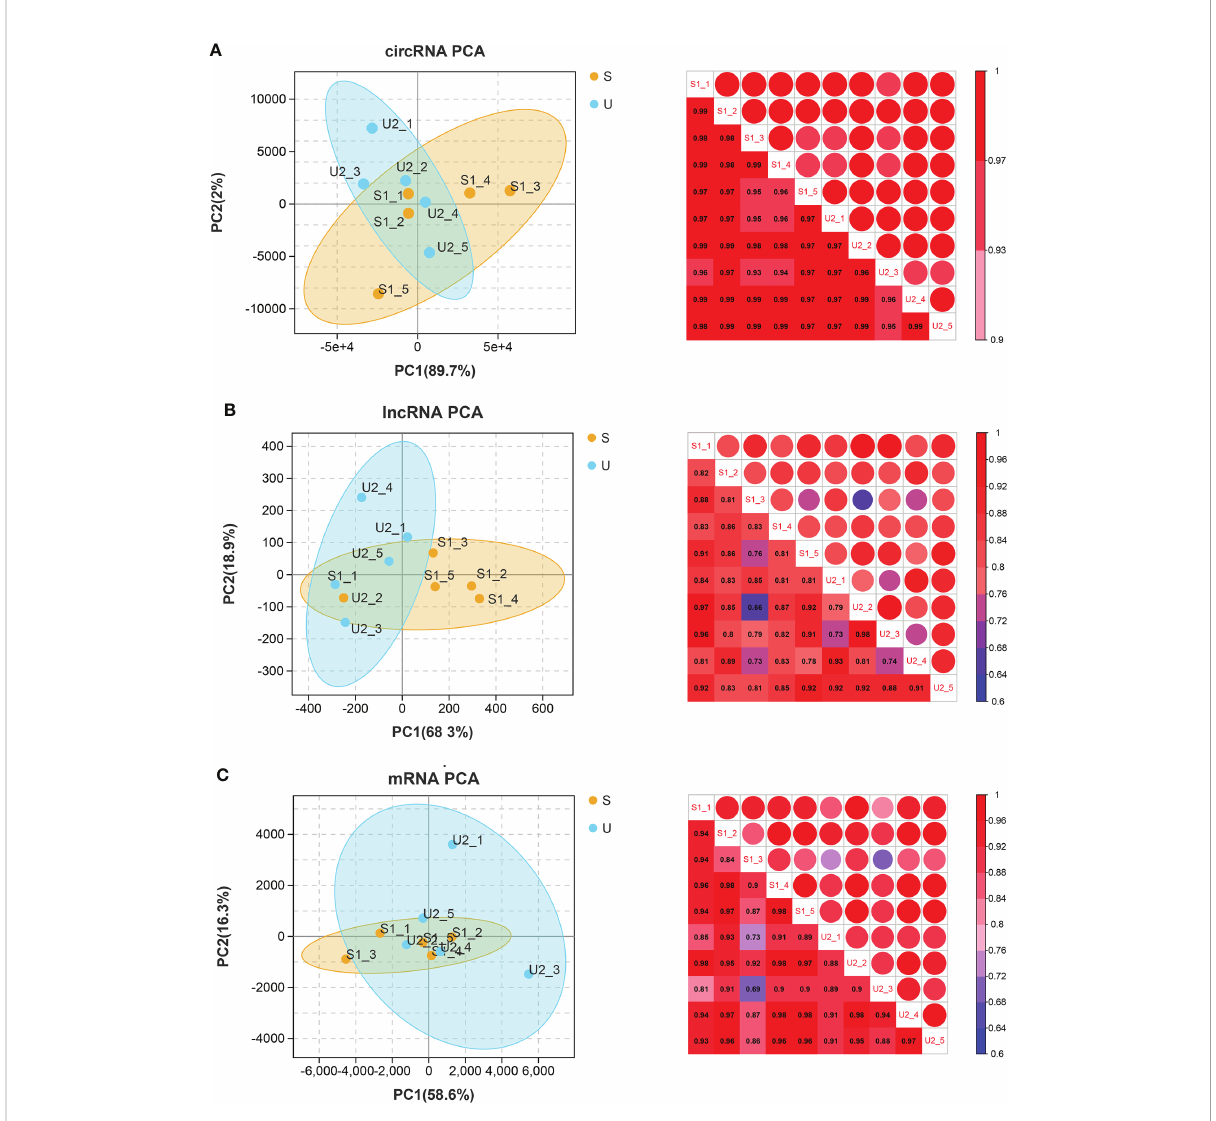
FIGURE 1 circRNA (A) , lncRNA (B) , and mRNA (C) . Left: PCA map of samples based on expression abundance. X, Y, and Z axes represent PC1, 2, and 3 respectively. Dots of different colors represent samples of different groups (S represents the stable group and U represents the unstable group); Right: heatmap of correlation between two samples based on expression abundance. The change of color from cold color to hot color indicates the relationship of the correlation coef fi cient between samples from small to large, the horizontal and vertical axes represent the name of samples, and the numbers in each grid represent the value of correlation coef fi